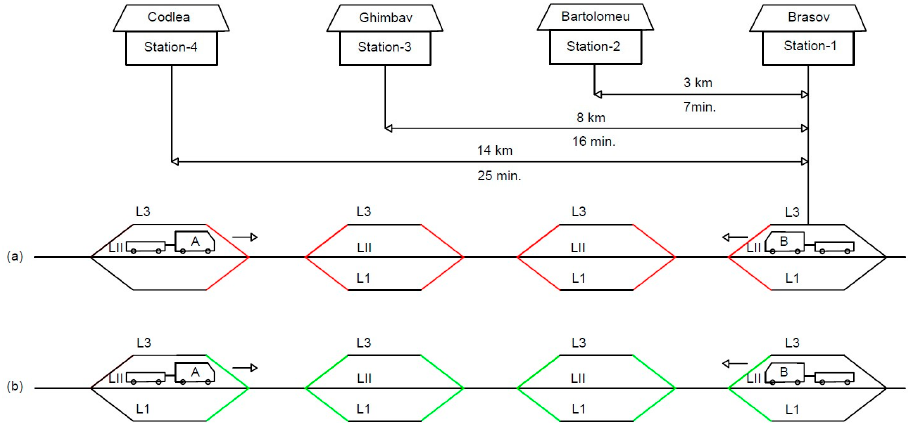
Figure 13. Layout of the four railway stations. ( a ) The red colored route represents the blocked turnouts that do not allow access to adjacent lines, and ( b ) the same route but with turnouts and adjacent lines in operation, depicted in green. A,B = trains; L = rail line, Roman numerals = direct lines, Arabic numerals = branching lines.